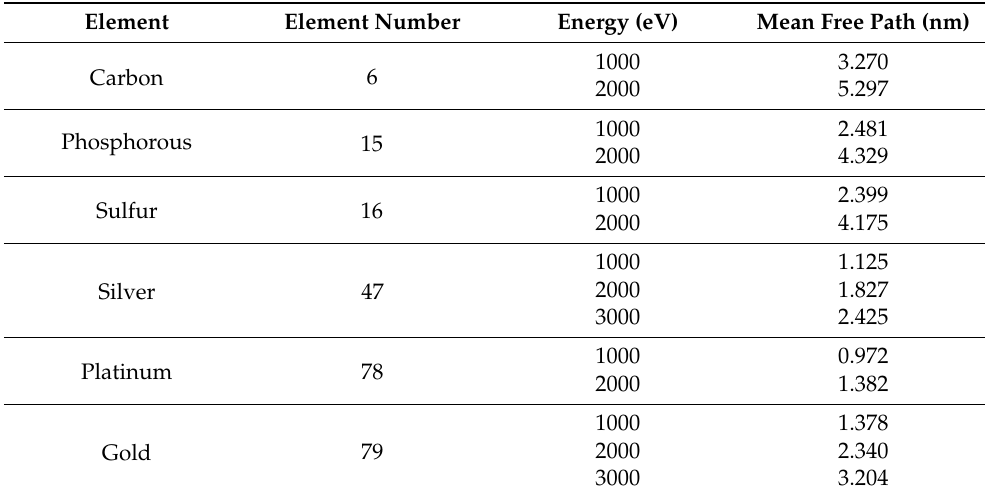
Table 1. Inelastic mean free path of different elements and energy from the database. The data were extracted from Ref.